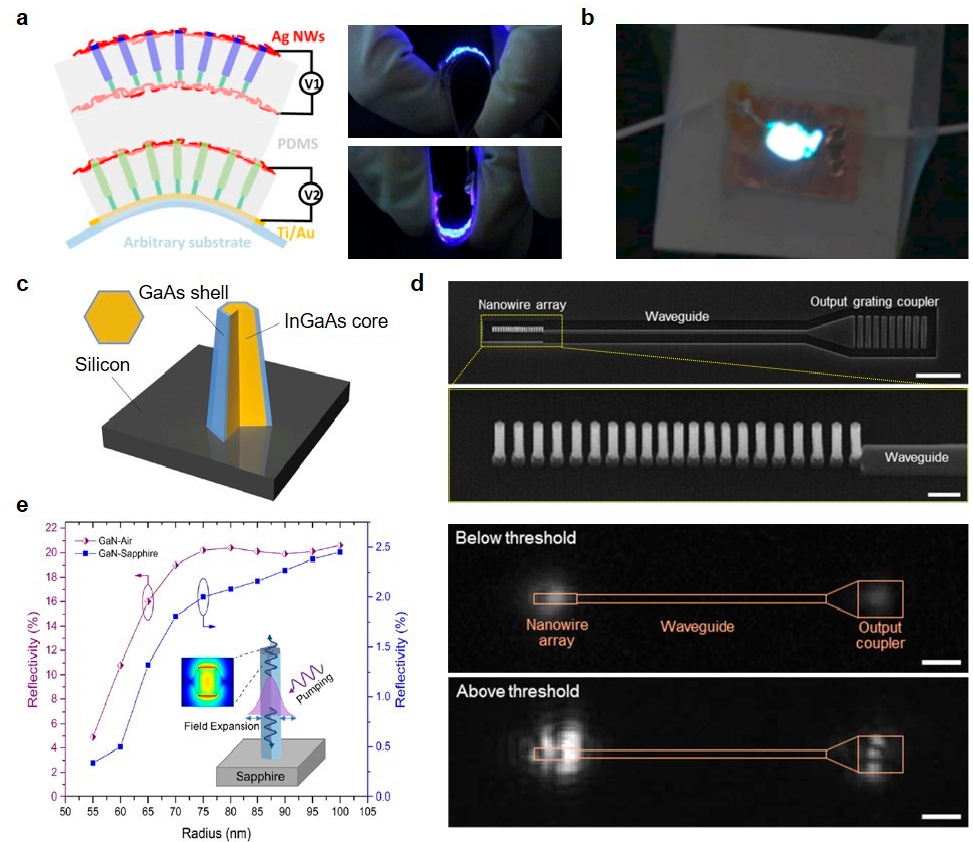
Figure 4. ( a ) Left: Schematic of the flexible nanowire LEDs. Right: Photographs of the mechanical flexibility of the vertical nanowire LEDs. ( b ) Photograph of the flexible white nanowire LEDs. ( c ) Schematic of the nanolaser integrated on the Si substrate. GaAs shell and InGaAs core are illustrated. ( d ) First row: SEM image of InGaAs nanowire array laser on SOI (Scale bar: 5 μ m). Second row: Close-up view SEM image of the nanowire array in the first row (Scale bar: 500 nm). Third, fourth rows: Emission patterns of the nanowire array laser are presented (Scale bar: 5 μ m). Interference patterns above the lasing threshold. ( e ) Simulated reflectivity of the HE 11 mode on GaN-Air and GaN-sapphire interfaces. ( a ) Reprinted with permission from [91]. Copyright 2015 American Chemical Society; ( b ) reprinted with permission from [92]. Copyright 2016 American Chemical Society; ( c ) reprinted by permission from Springer Nature: Springer Nature photonics [99], Copyright 2011; ( d ) reprinted with permission from [100]. Copyright 2017 American Chemical Society; ( e ) reprinted with permission from [101]. Copyright 2018 American Chemical Society.